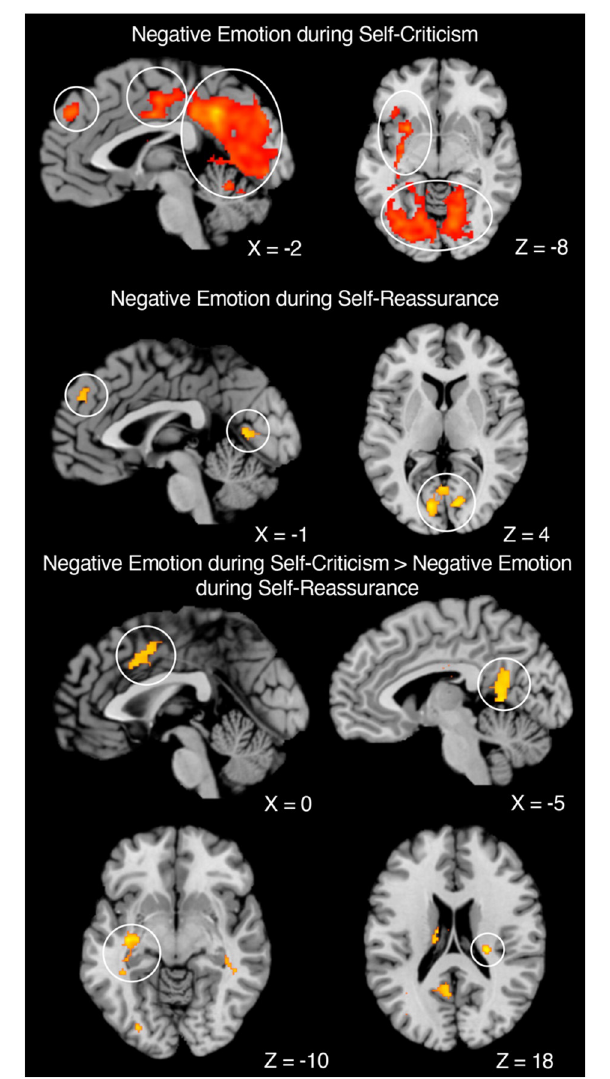
FIGURE 2 | Neural markers of negative emotion across self-criticism and self-reassurance. Negative Emotion during Self-Criticism: Left . Sagittal image of MPFC (Left Circle), ACC (Middle Circle), and Left Lingual Gyrus and Cerebellum (Right Circle). Right . Axial image of Subcortical Regions (Top Circle) and Bilateral Visual Cortex (Bottom Circle). Negative Emotion during Self-Reassurance: Left . Sagittal image of MPFC (Left Circle) and Visual Cortex (Right Circle). Right. Axial image of Visual Cortex. Negative Emotion during Self-Criticism—Negative Emotion during Self-Reassurance: Top Left . Sagittal image of ACC. Top Right . Sagittal image of posterior cingulate. Bottom Left . Axial image of left putamen. Bottom Right . Axial image of Right Hippocampus. Coordinates reported in MNI-space. N =